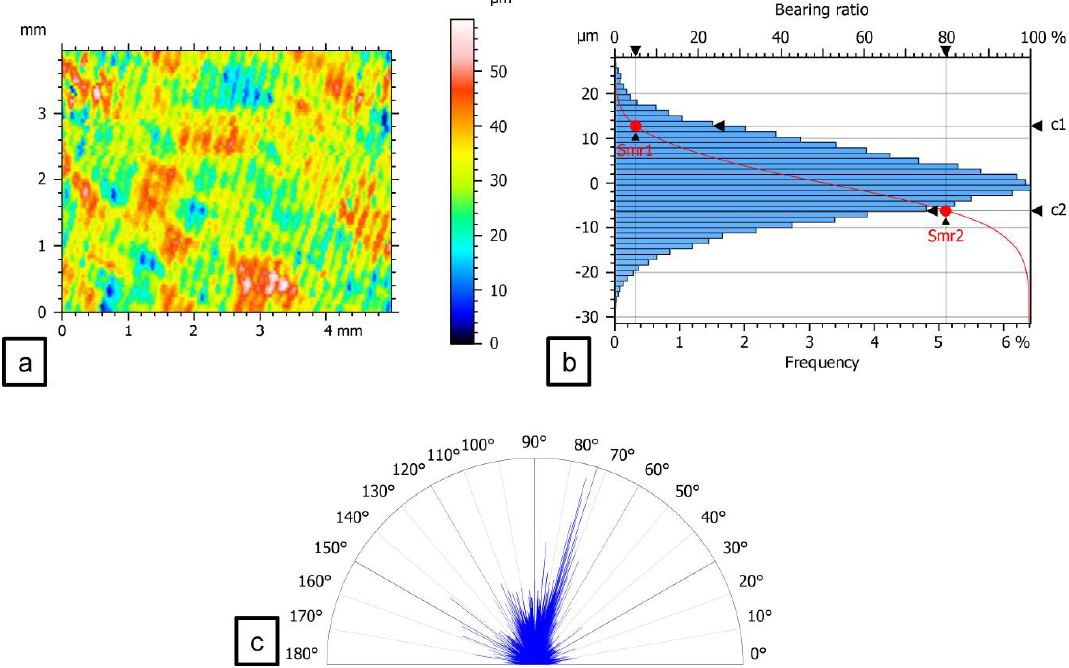
Figure 6. Pseudo-color view of the 0° slope surface: ( a ) histogram and Abbot curve ( b ), as well as polar spectrum graph ( c ). Table 4. Primary surface, spatial parameters, and functional parameters for the 0° slope surface.